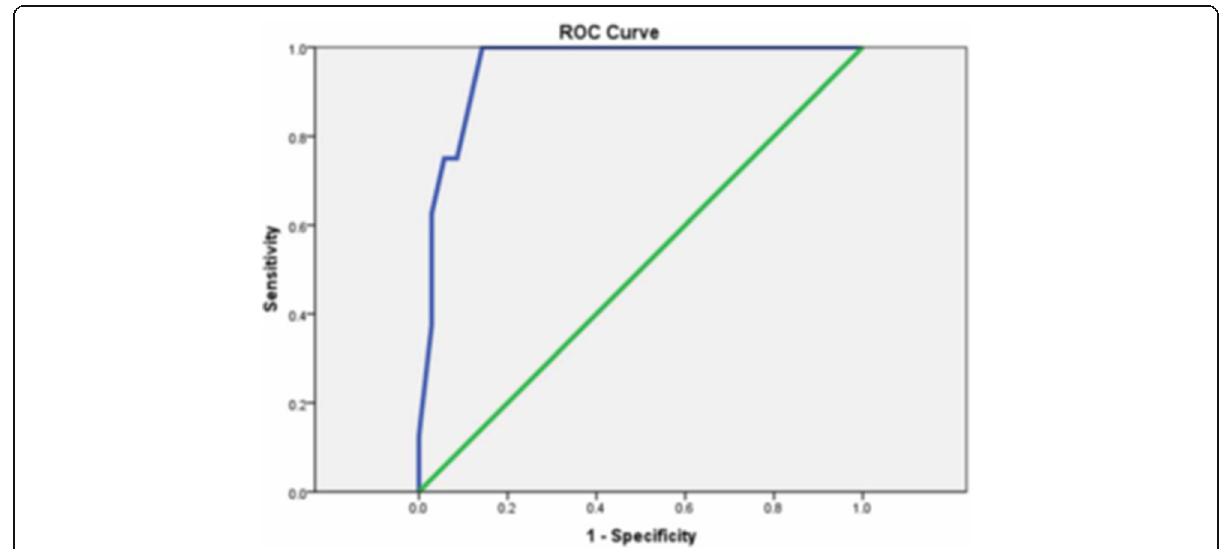
Fig. 1 Sensitivity and specificity test for MRI T2 lesion number in prediction of conversion of